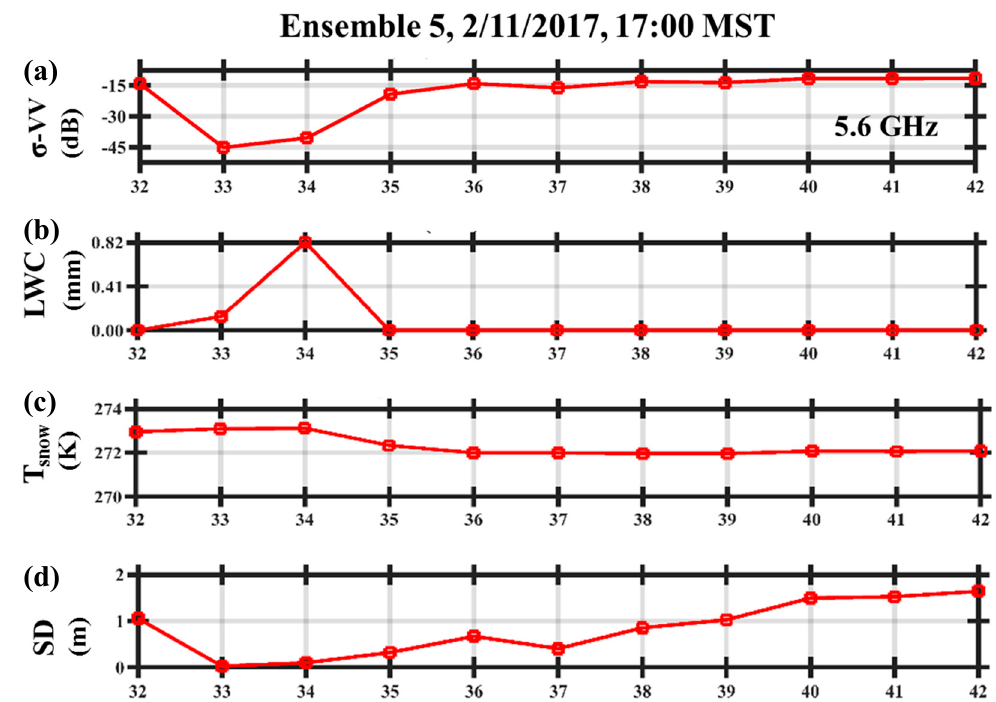
Figure 11. ( a ) Backscattering behavior of σ -VV at 5.6 GHz and snowpack properties along the west–east transect formed by Ensemble 5 Members 32–42 in Grand Mesa (see maps in Figures 1 and S1). ( b ) Liquid water content in the top snow layer. ( c ) Temperature of the top snow layer. ( d ) Snowpack depth. MST-Mountain Standard Time = UTC-7.